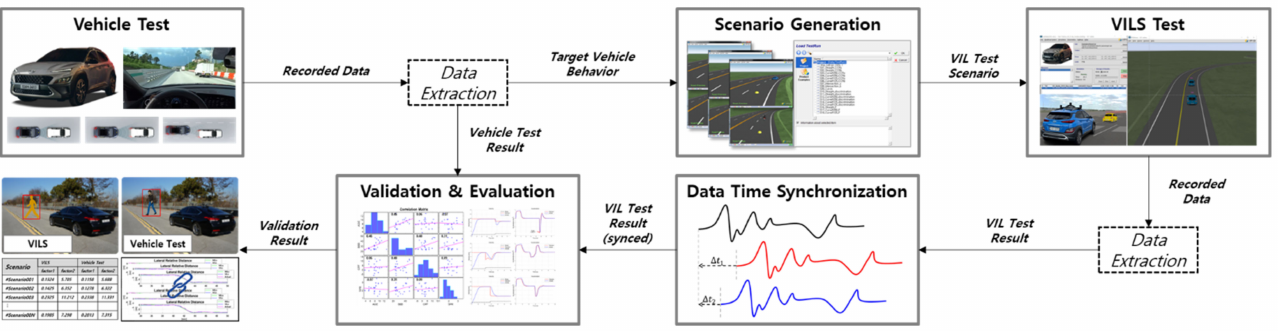
Figure 13. Vehicle Test—VILS Test Validation